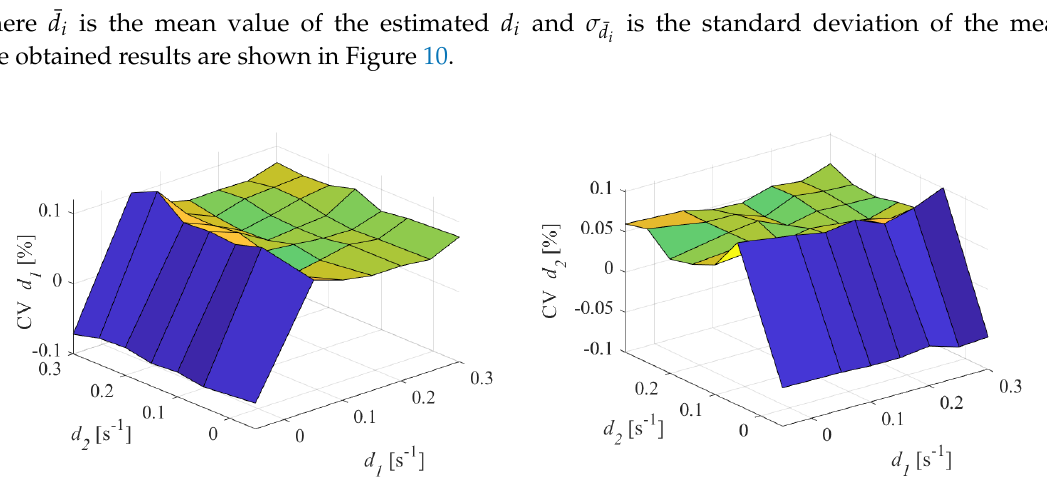
Figure 10. Coefficient of variation (CV) versus damping coefficients obtained in numerical tests with noise and quantization; results for frequency f 1 ( on the left ) and f 2 ( on the right